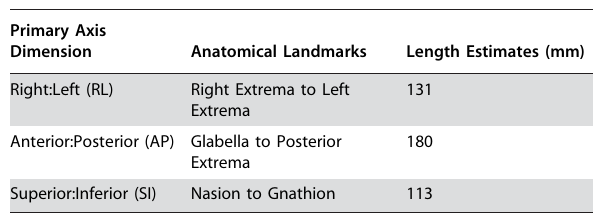
Table 1. Dimension Estimates of Authentic Phineas Gage Table 2. Gillespie Ratings of Visual Information and